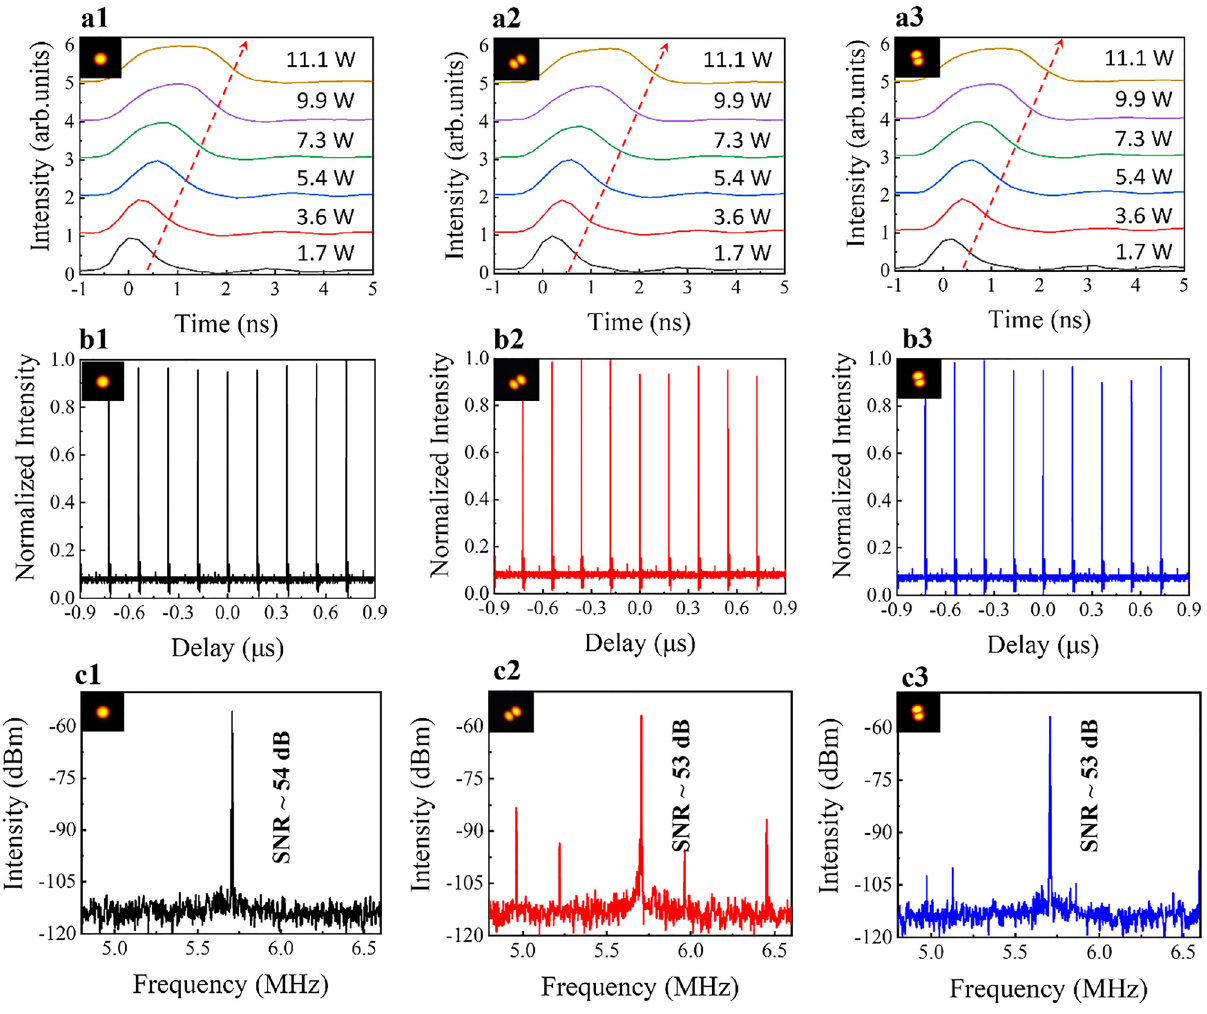
Figure 10: The pulse width as the pump power increases. Pulse shape evolution for the pump powers of (a1) LP 01 mode, (a2) LP 11a mode, and (a3) LP 11b mode. (b1) – (b3) Typical ML pulsed traces and (c1) – (c3) RF spectra at the fundamental frequency of LP 01 and LP 11a/b